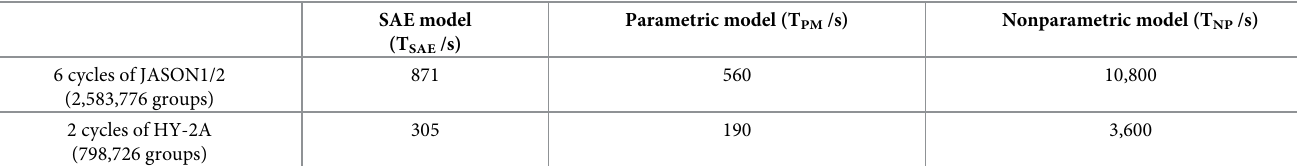
Table 2. Model execution times.